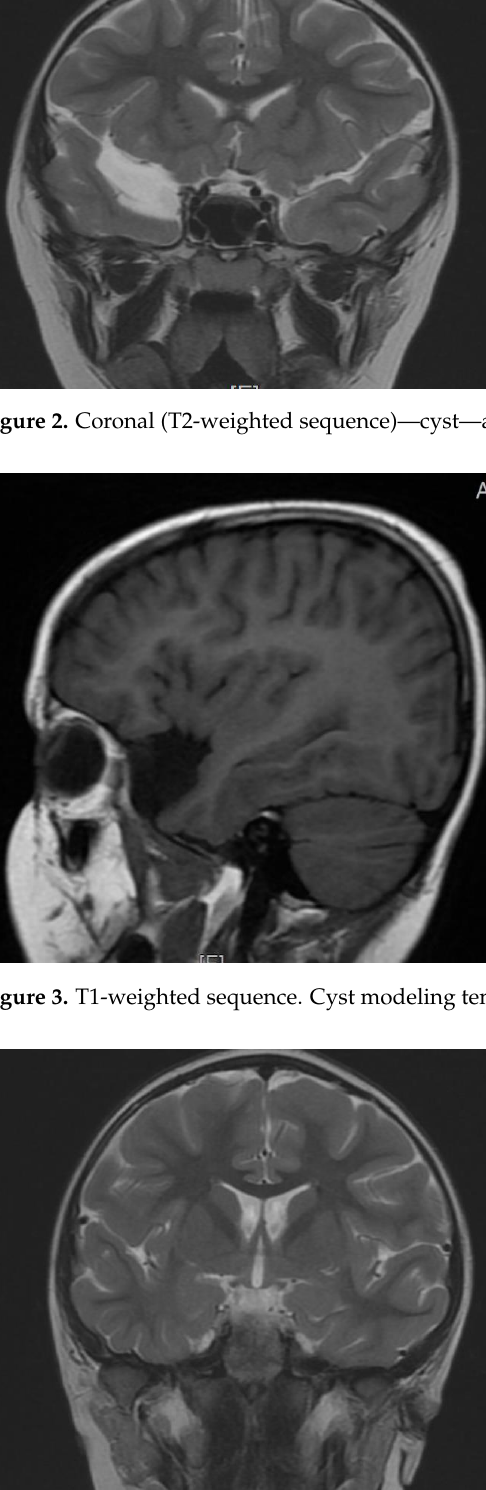
Figure 4. Coronal (T2-weighted sequence). Slight delayed myelination.